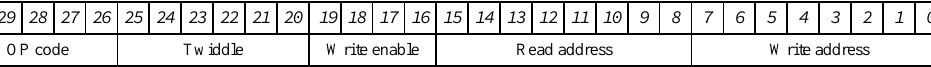
Figure 11: The format of the